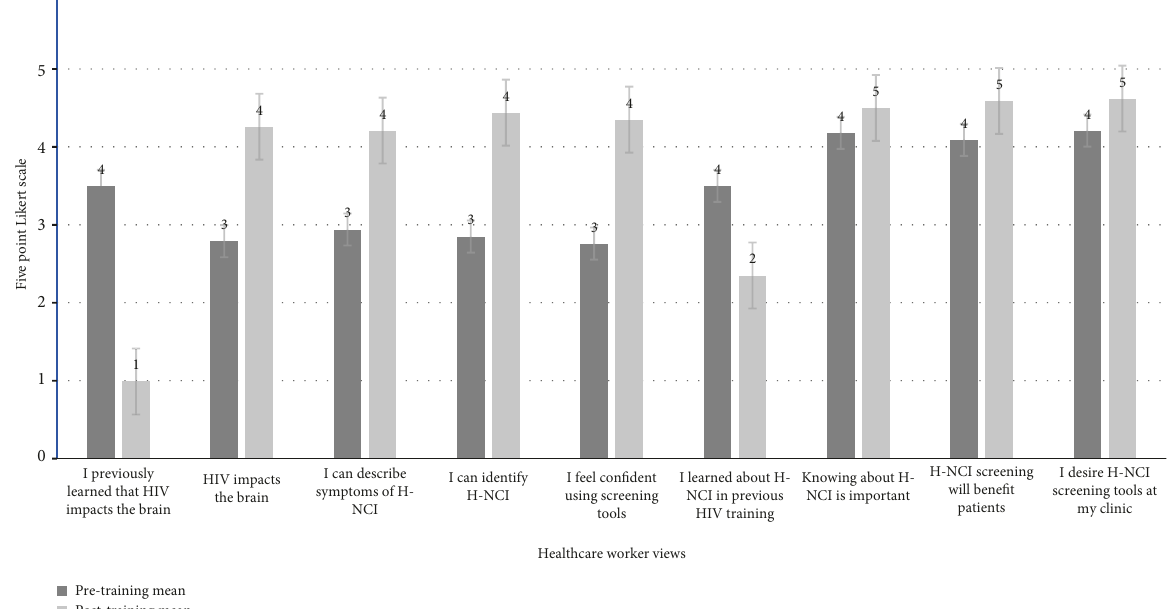
Figure 3: Healthcare worker views on HIV-associated NCI pre-training and post-training. Note : 5-point Likert scale. 0: strongly disagree, 1: disagree, 2: I do not know enough to answer, 3: agree, and 4: strongly agree